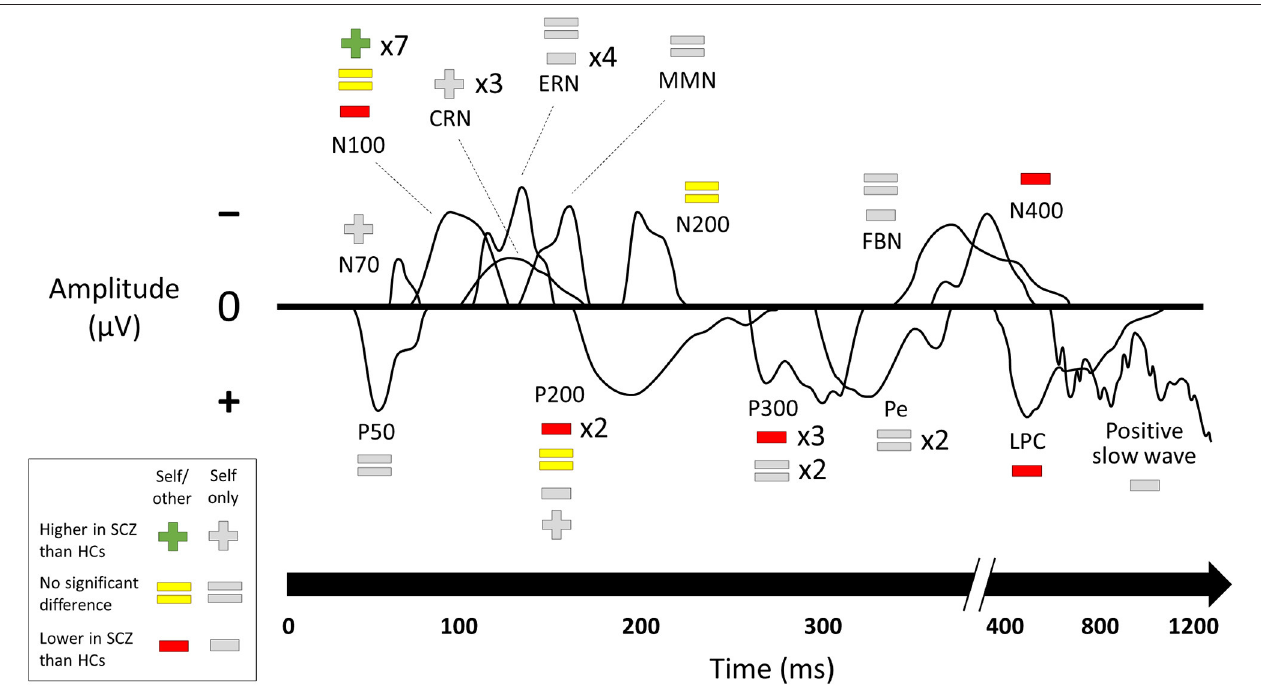
FIGURE 3 | Changes in ERP component amplitudes including null results. Studies that compared ERP component amplitudes in subjects with schizophrenia to those in healthy controls. SCZ, subjects with schizophrenia. HCs, healthy controls. Multipliers beside a plus, equals, or minus sign indicate the number of studies that reported this result. Studies marked as “self/other” compared self-related task data to comparable non-self-related task data to establish a role for the self. Studies marked as “self only” used a self-related task but without a control condition to establish that it was this aspect of the task that caused the ERP component change. The visual depictions of ERP components are stylized approximations that do not correspond to the findings of any of the studies in particular. A few ERP components were not named in the studies and were categorized here based on their latency and whether they were positive- or negative-going. Results of the individual studies can be found in the Supplementary Material .